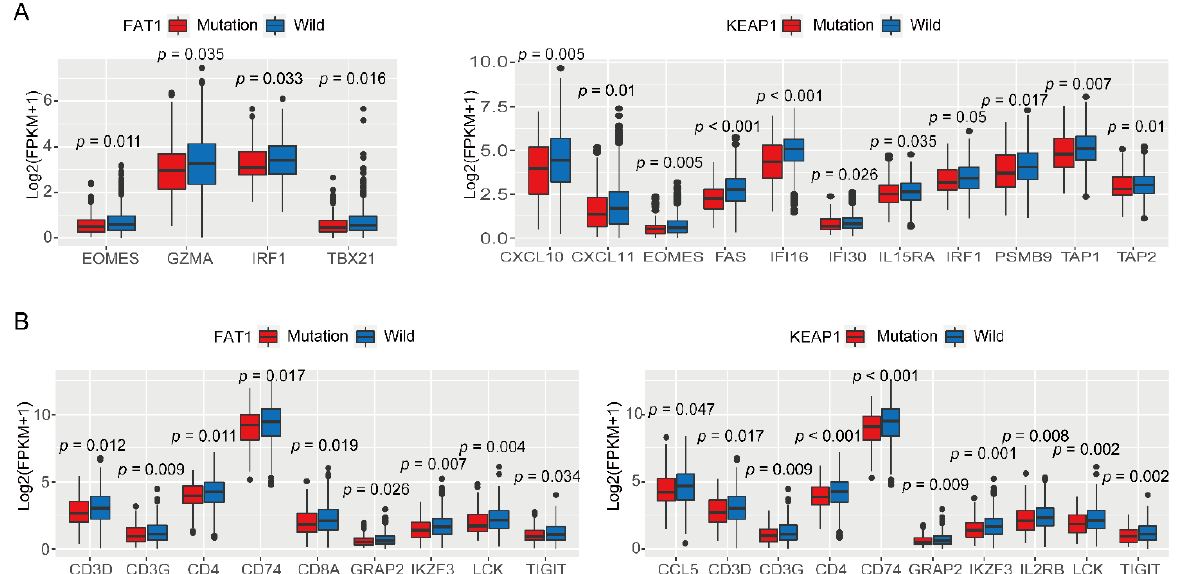
Figure 5. Expression of immune-regulatory genes. ( A ) T-cell effector and IFN- γ -associated gene signatures; ( B ) T-cell receptor (TCR)-related genes.